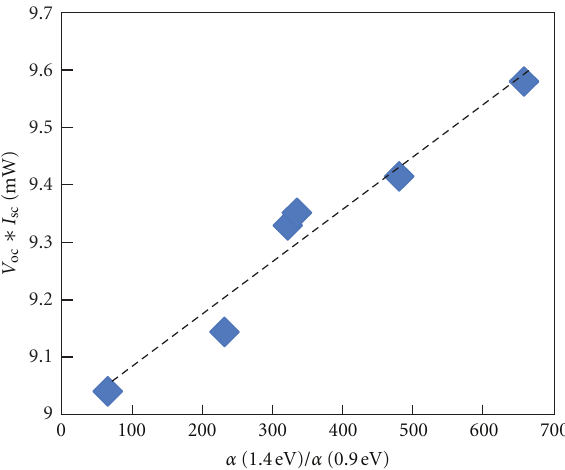
Figure 4: Relation between quality factor and V oc ∗ I sc .